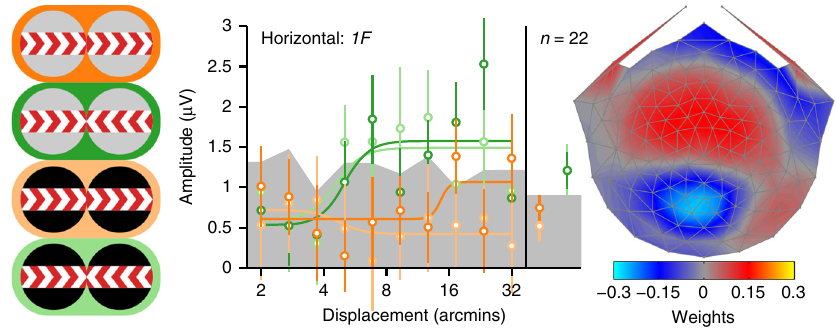
Fig. 7 Infant fi rst harmonic SSVEP response functions. Averages across all displacements are shown on the right side of the response functions. Unlike previous plots, data are plotted for the fi fth reliable component because its topography was most similar to the topography of the adults. The scalp topography for this component is shown on the right, with the color scale indicating the component weights. The conditions are represented with the icons on the left, with the same color convention as in previous fi gures. Smooth curves are fi ts from a Naka – Rushton function. Error bars are ±1 SEM, and the gray band indicates the average EEG noise